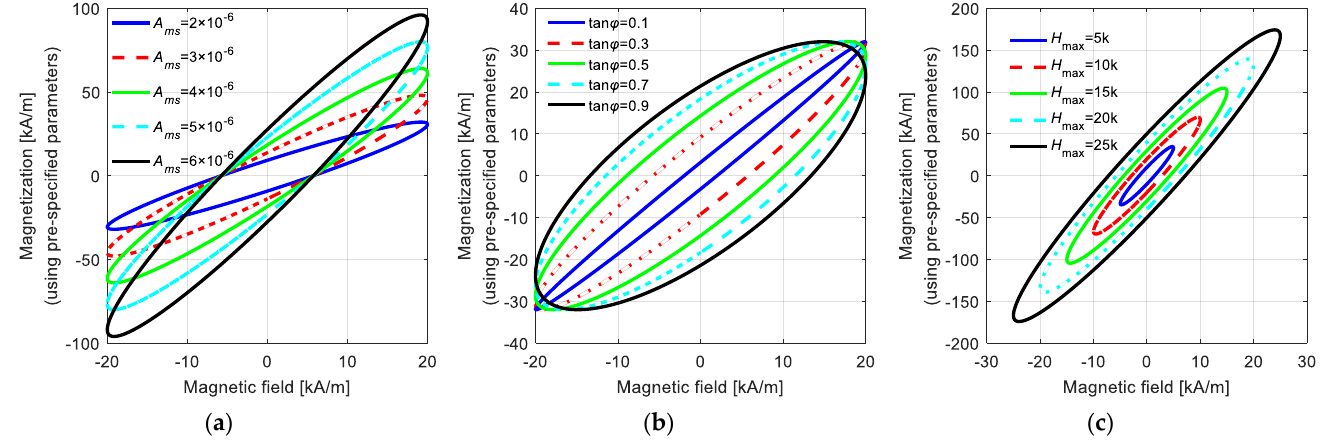
Figure A1. Various hysteresis loops described by the 1st − order LTI system model: ( a ) M − H curves with different values of A ms ; ( b ) M − H curves with different values of φ ; ( c ) M − H curves with different values of H max .